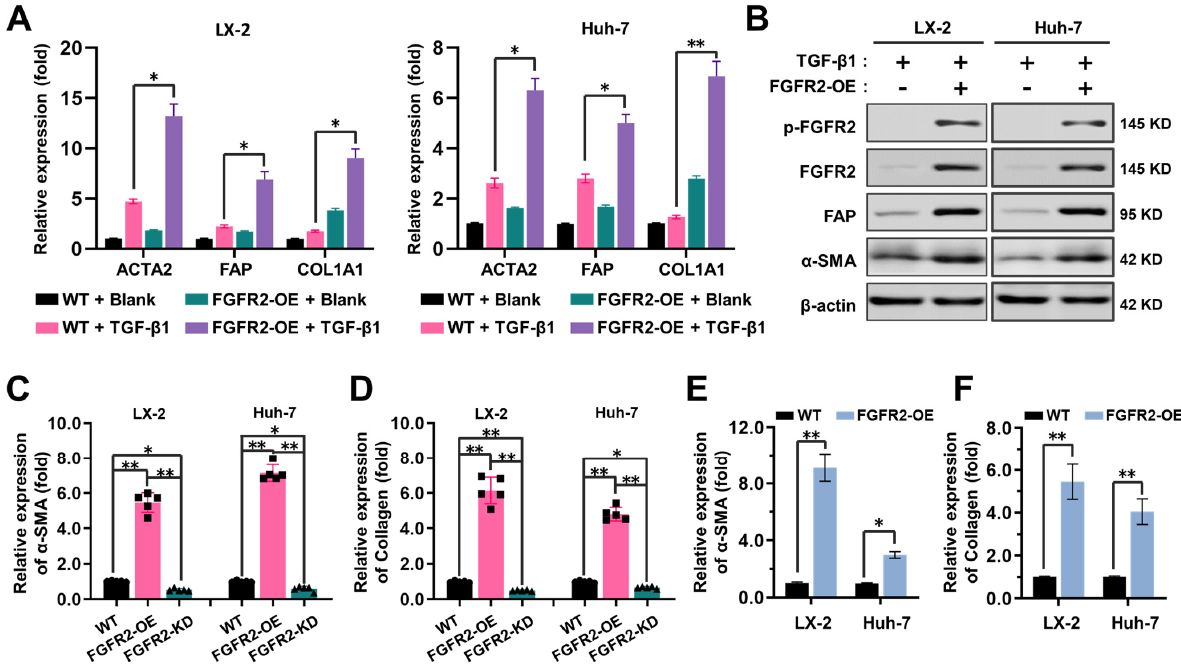
Figure 2. FGFR2 drives the process of liver fibrosis. ( A ) The expression of liver fibrosis markers (ACTA2, fibroblast activation protein alpha (FAP), alpha-1 type I collagen (COL1A1)) was measured by qPCR. The samples were divided into four groups according to whether cells were induced with or without TGF- β and whether cells were overexpressed by FGFR2. ( B ) The expression of markers in wild-type and FGFR2-OE cell lines under TGF- β induction was analyzed by Western blot analysis. ( C ) The expression levels of α -SMA and ( D ) collagen secretion in LX-2 and Huh-7 were evaluated, when FGFR2 was overexpressed or knocked down upon equal TGF- β induction. ( E ) Cells were collected after 48 h of co-culture, and the expression of α -SMA and ( F ) type I collagen in the lower layer cells was determined by ELISA. The results are marked as significant “*” when p < 0.05, “**” when p < 0.01, and not significant (ns) if p ≥